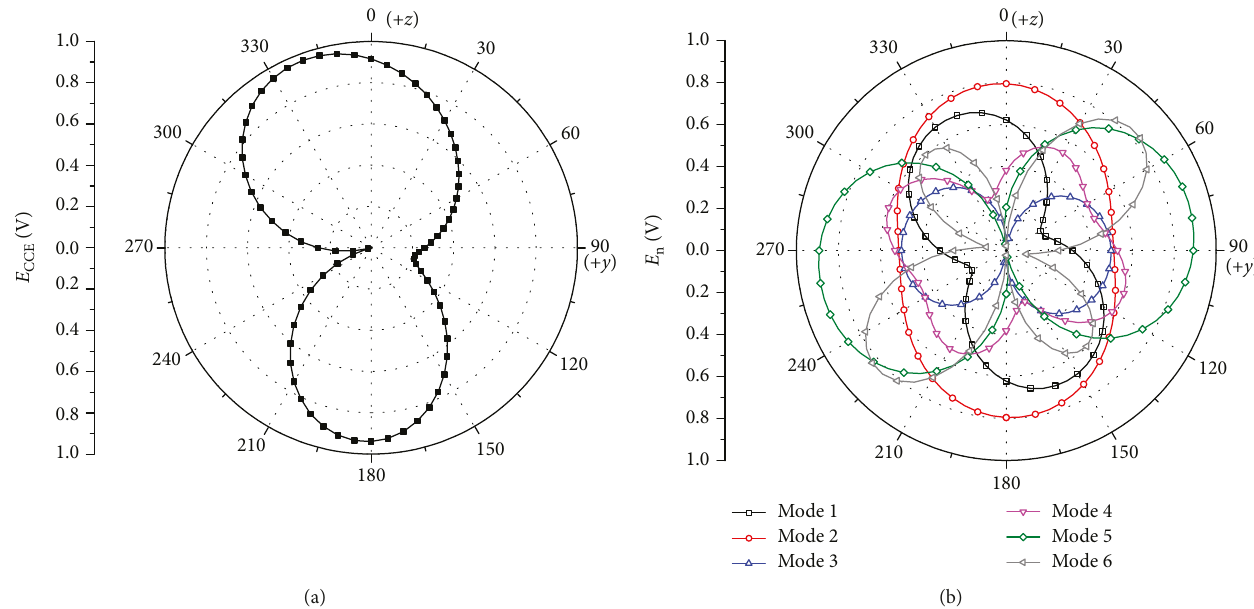
Figure 6: Radiation patterns of the total fi eld and the fi rst six modes for the CCE-fed antenna on the yoz plane of φ = 90 ° at 2.2GHz: (a) total fi eld using the full-wave method and (b) far fi eld for the fi rst six